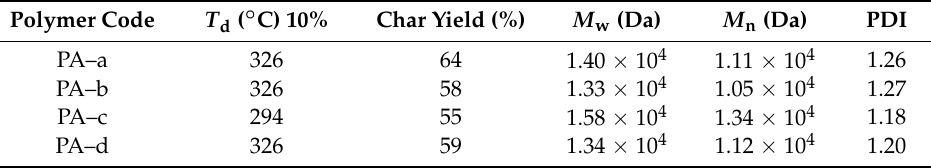
Table 1. Thermal properties and molecular weights of the PAs.